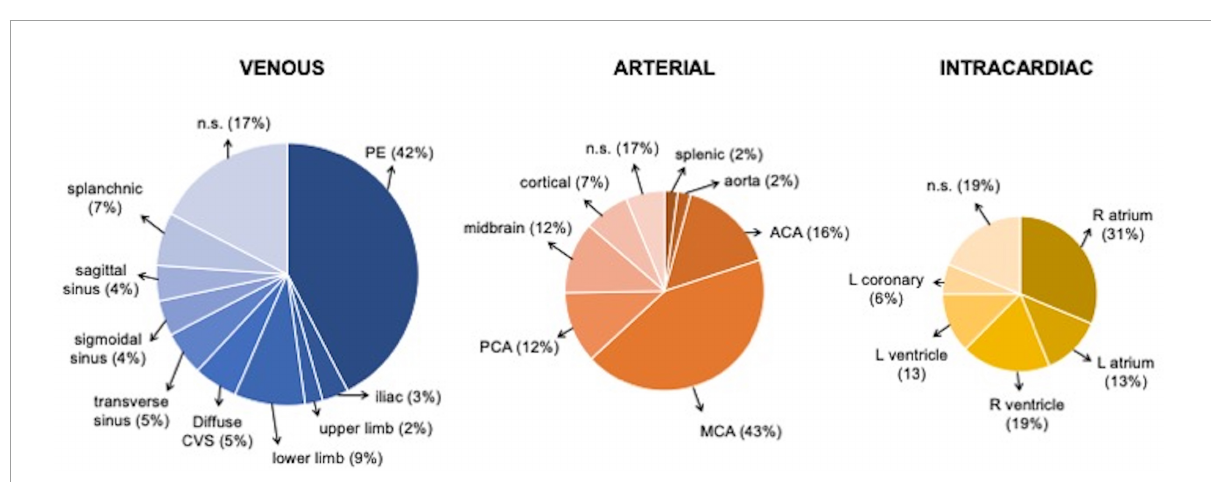
FIGURE3 Localization of Venous, arterial, and intracardiac TEs. ACA, anterior cerebral artery; CVS, cerebral venous sinus; L, left, MCA middle cerebral artery; PE, pulmonary embolism; PCA, posterior cerebral artery; R, right.